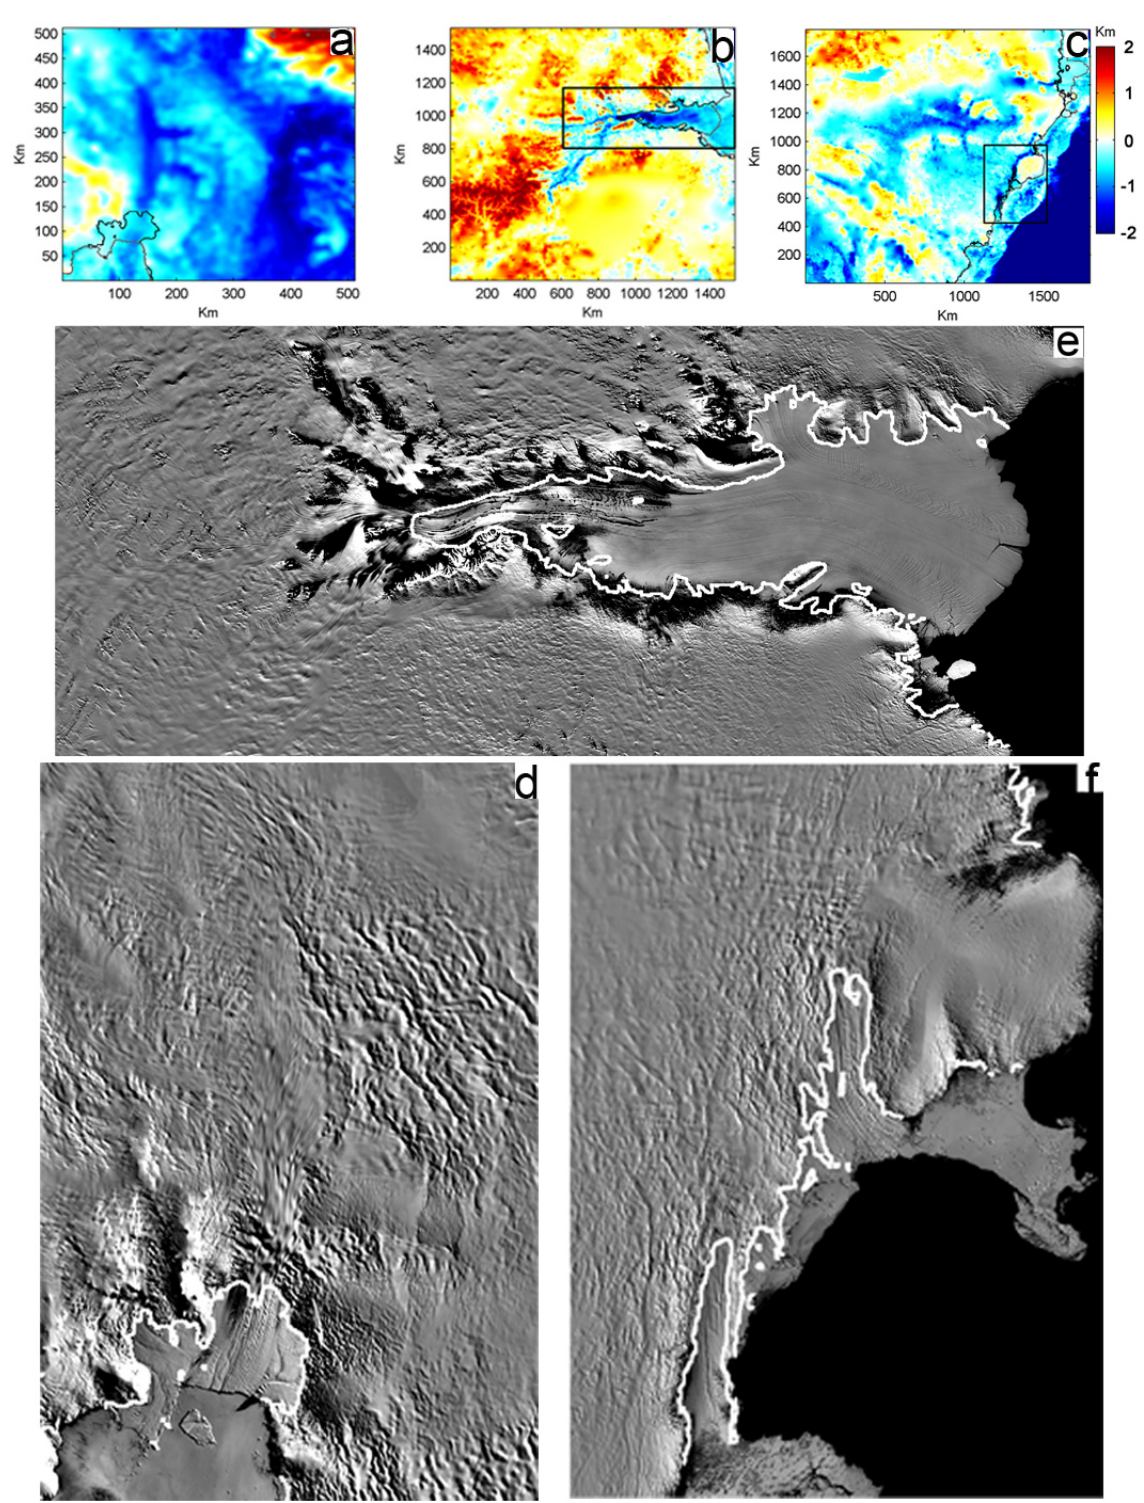
Figure 2. Bedrock topography map for PIG ( a ; Le Brocq, et al., 2010), LA ( b ; Fretwell et al., 2013) and AT ( c ; Fretwell et al., 2013). Grounding lines are shown in black. (d–f) are MODIS Mosaic of Antarctica (MOA) Image Map 2003–2004 images, (Scambos et al., 2007) of the boxed areas in (a–c) with grounding lines shown in